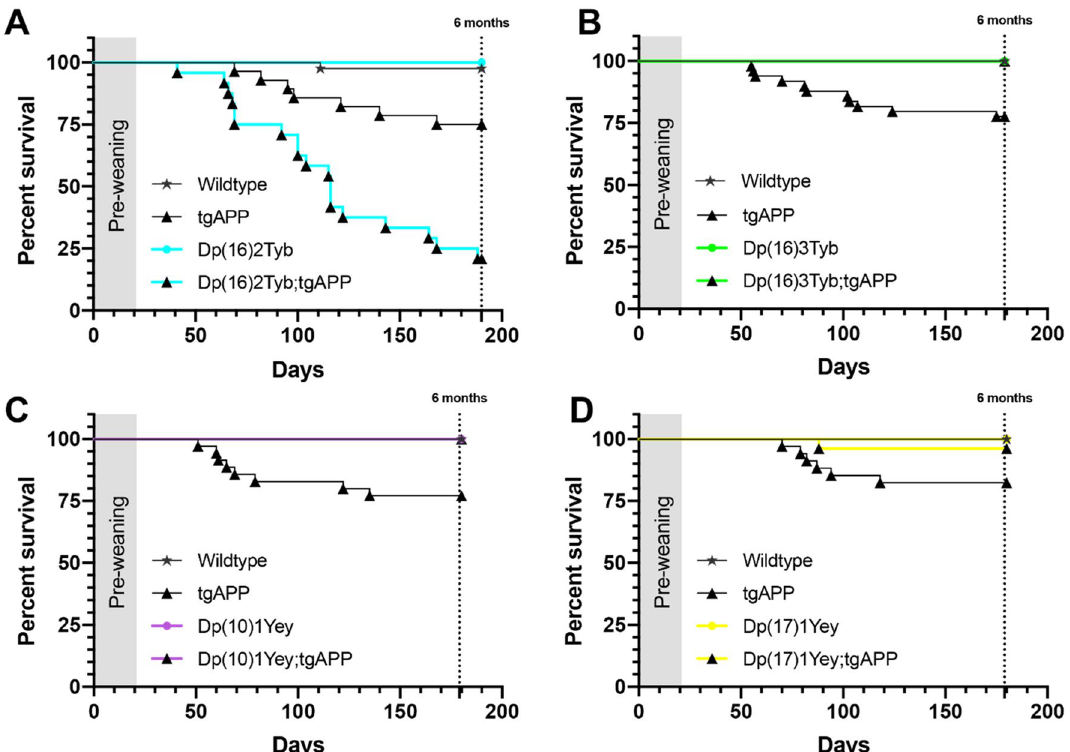
Figure 2. The effect of DS segmental duplication models on J20 tgAPP-associated mortality. ( A ) Survival of Dp(16)2Tyb;tgAPP male and female mice to 6-months of age is significantly reduced compared to tgAPP controls (Mantel–Cox log-rank test Χ 2 = 47.872 p < 0.001). (Wildtype male n = 21, female n = 16; Dp(16)2Tyb male n = 7, female n = 6; tgAPP male n = 16, female n = 12; Dp(16)2Tyb;tgAPP male n = 7, female n = 21). ( B ) Survival of Dp(16)3Tyb;tgAPP male and female mice to 6-months of age is significantly increased compared to tgAPP controls (Mantel–Cox log-rank test Χ 2 = 33.58 p < 0.001). (Wildtype male n = 23, female n = 34; Dp(16)3Tyb male n = 19, female n = 20; tgAPP male n = 21, female n = 28; Dp(16)3Tyb;tgAPP male n = 18, female n = 20). ( C ) Survival of Dp(10)1Yey;tgAPP male and female mice to 6-months of age is significantly increased compared to tgAPP controls (Mantel–Cox log-rank test Χ 2 = 8.414 p = 0.004). (Wildtype male n = 15, female n = 23; Dp(10)1Yey male n = 19, female n = 27; tgAPP male n = 17, female n = 18; Dp(10)1Yey;tgAPP male n = 11, female n = 22). ( D ) Survival of Dp(17)1Yey;tgAPP male and female mice to 6-months of age is significantly increased compared to tgAPP controls (Mantel–Cox log-rank test Χ 2 = 12.56 p = 0.0057). (Wildtype male n = 14, female n = 18; Dp(10)1Yey male n = 11, female n = 15; tgAPP male n = 16, female n = 18; Dp(10)1Yey;tgAPP male n = 12, female n = 14). Both sexes included in